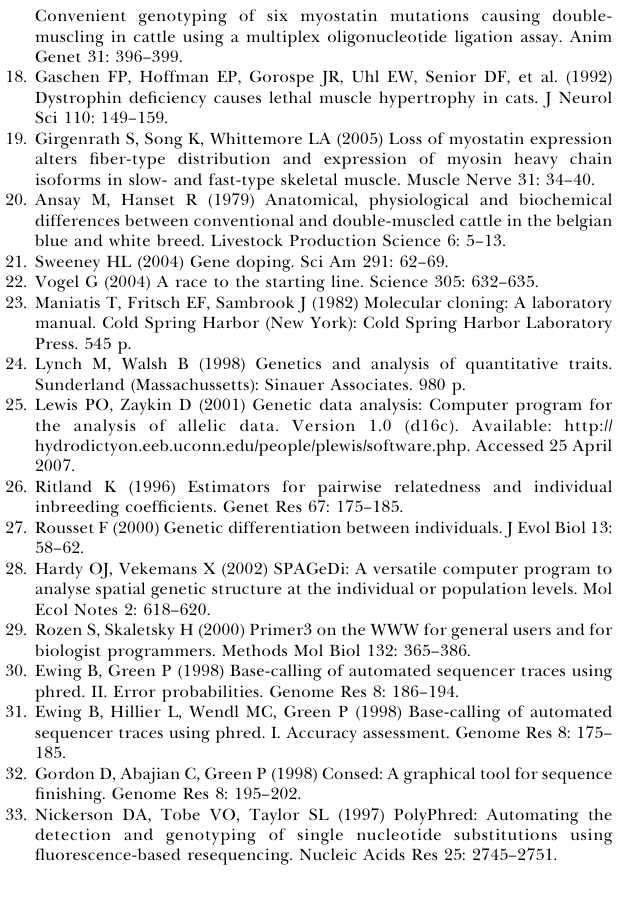
(A) Empirical cumulative distribution of p -values (open circles). The solid line represents the expected distribution under the null hypothesis of no association between genotype and racing grade. (B) Histogram of p -values on a log scale showing the location of the p - value for the 2-bp